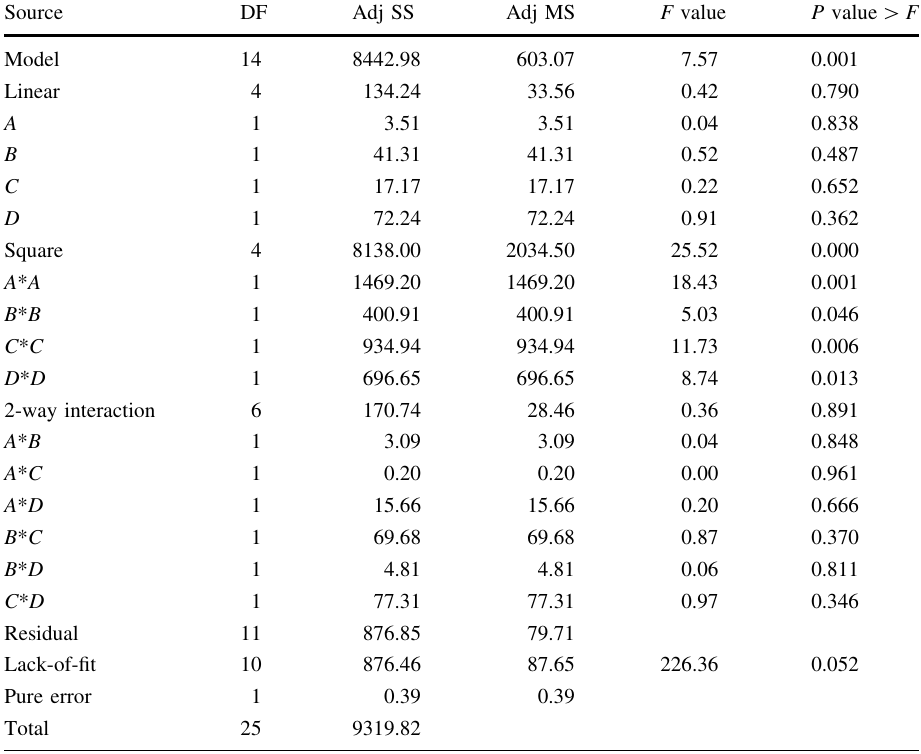
Table 5 Analysis of variance for %